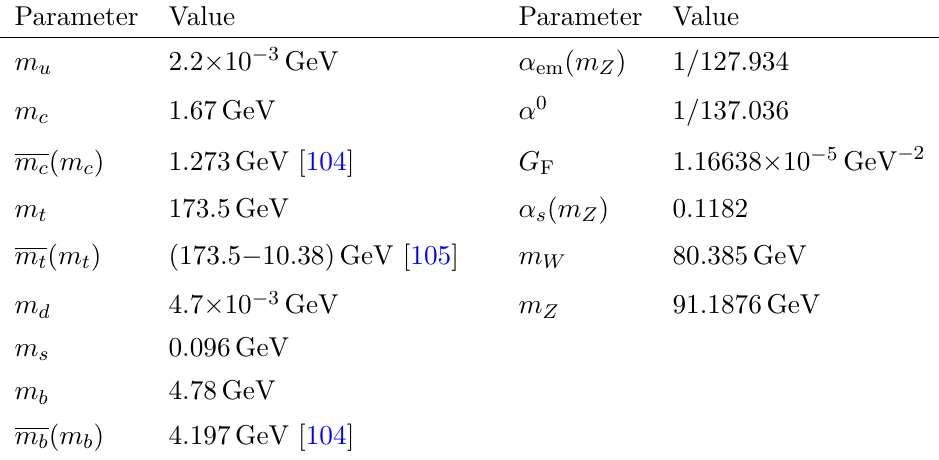
Table 8 . Standard Model values used for global scan, attained from ref. [16] where not explicitly stated otherwise. Parameters dependant on scale are normalised in the MS scheme while non scheme dependant masses are assumed to be given as pole